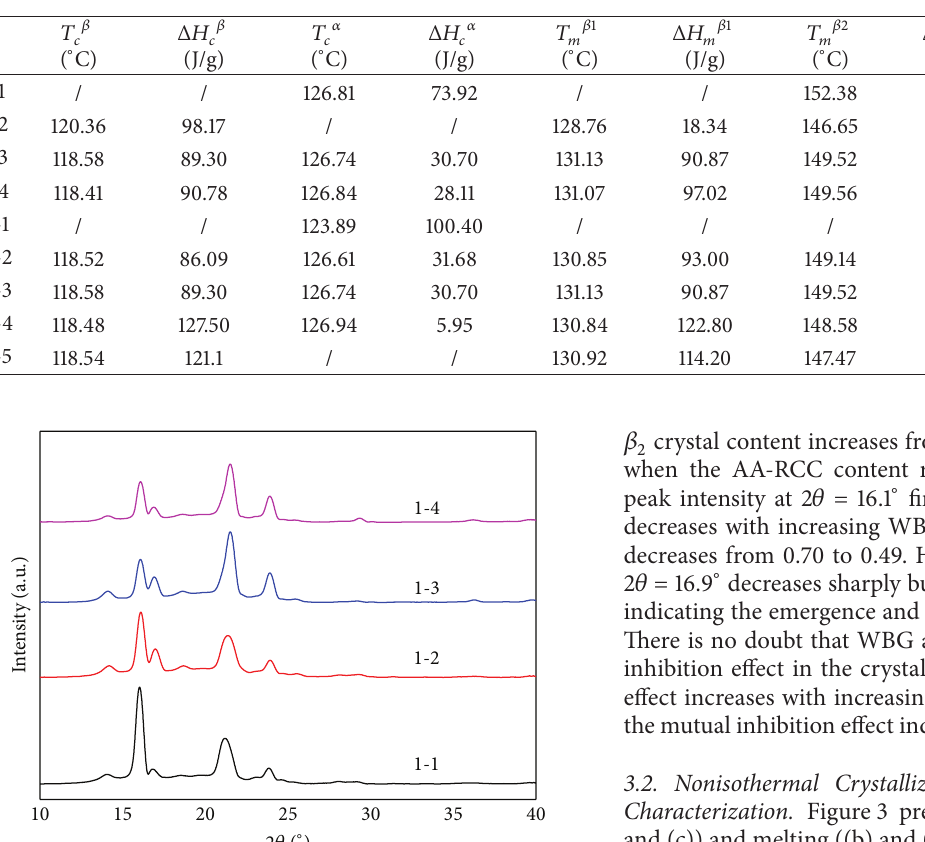
Table 3: Nonisothermal crystallization kinetics parameters of WBG/AA-RCC/PP.